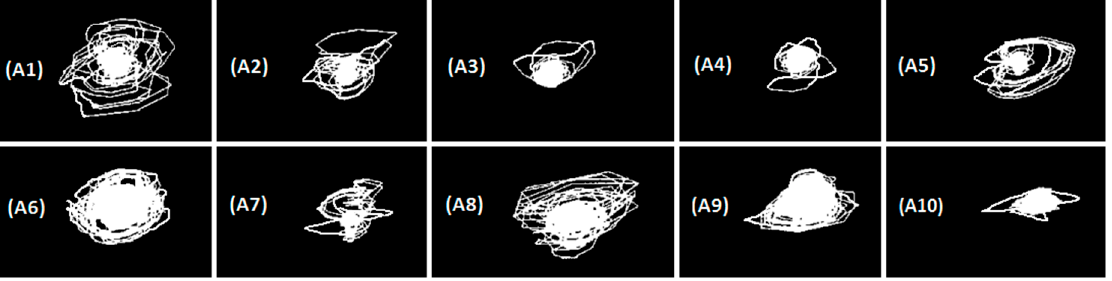
Figure 6. Phase-space state portraits of the EEG time series (Figure 5) included in the study.